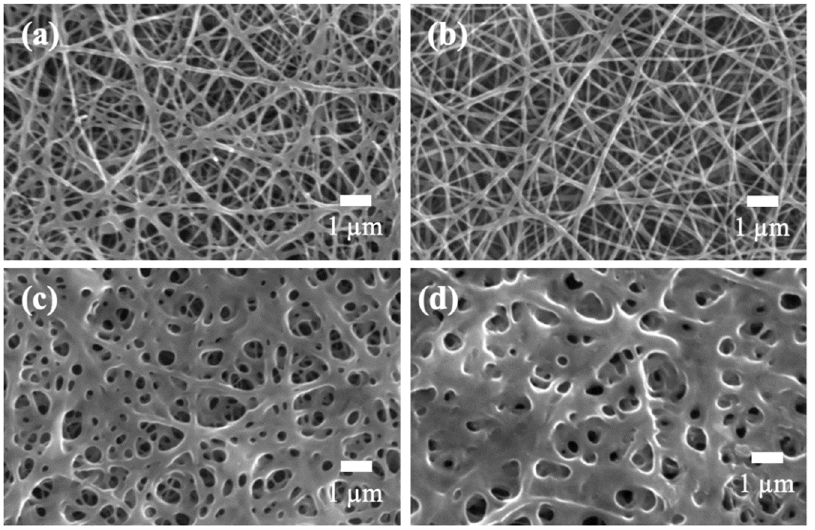
Figure 4. SEM images of CS/PCL nanofibers expose to APNP for ( a ) 5; ( b ) 40; ( c ) 200; and ( d ) 380 s.